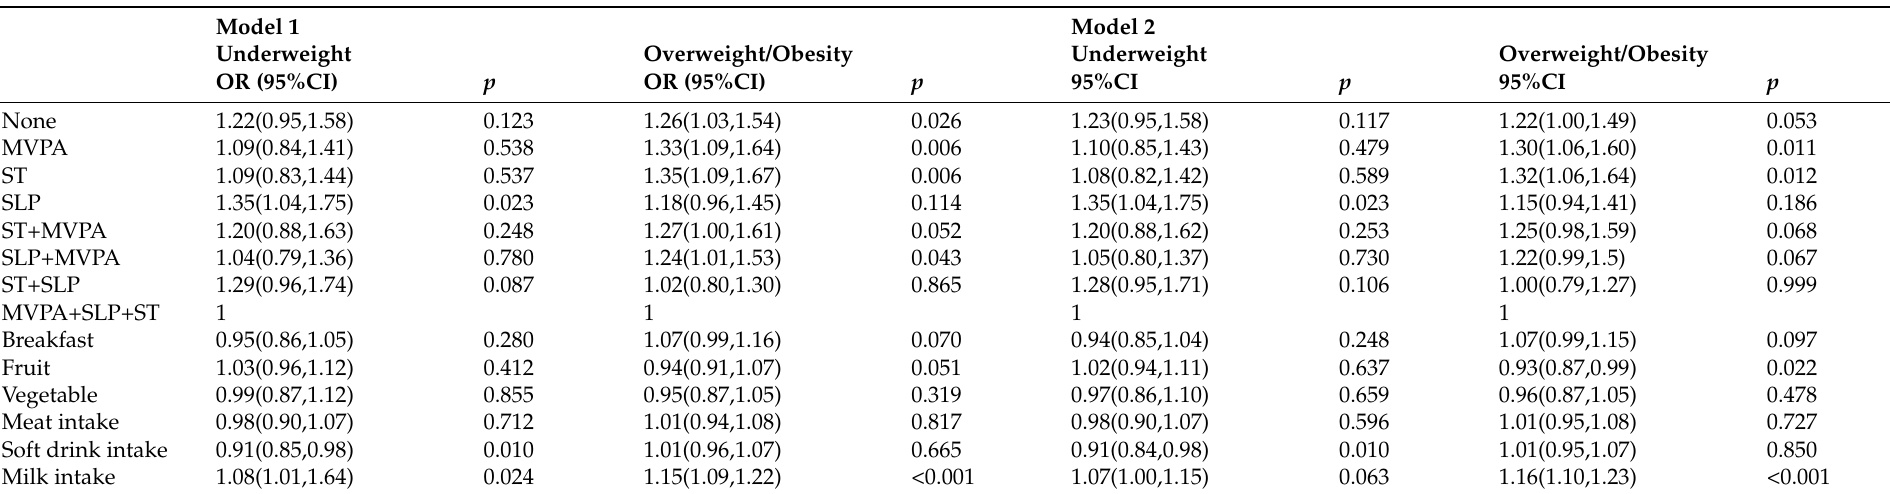
Table 4. Logistic regression analysis of the associations between meeting 24 h movement and dietary guidelines and weight